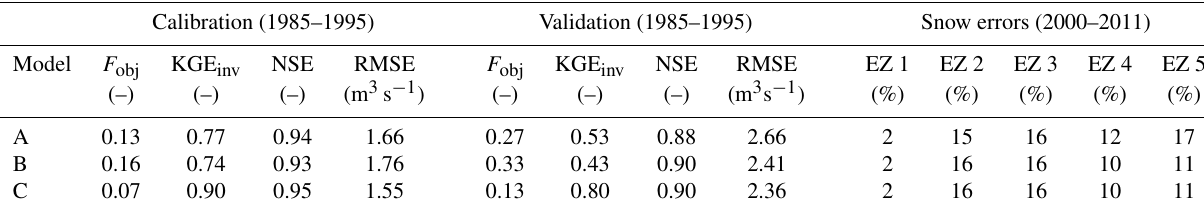
Table 4. Goodness-of-fit (calibration) and predicting performance (validation) of the hydrological models. Calibration